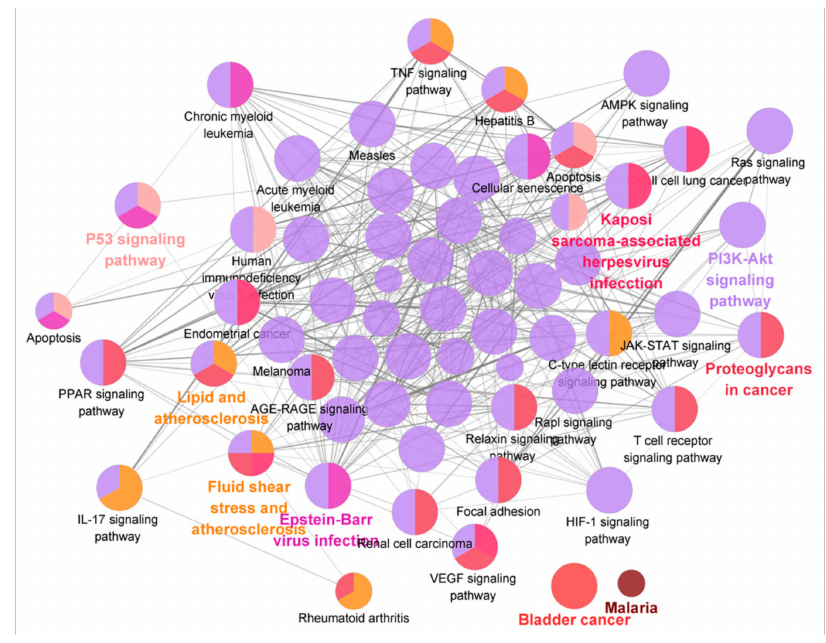
Figure 9. Pathway enrichment analysis of 15 characteristic components using